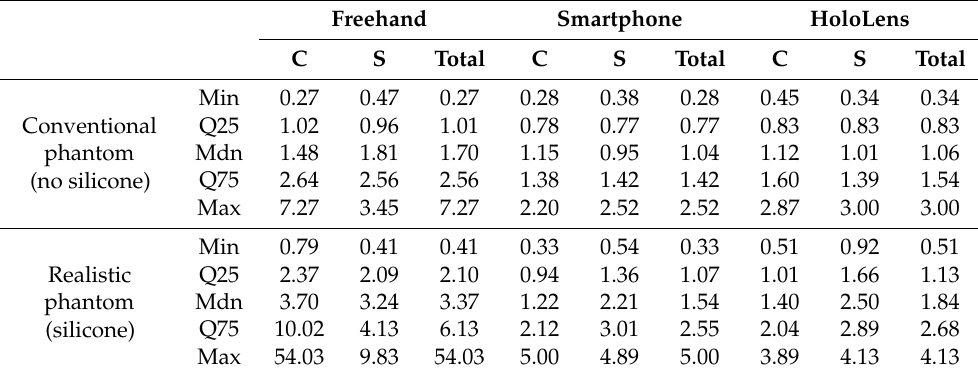
Table 1. Descriptive statistics of maximum osteotomy deviations for each phantom. Q25 and Q75 represent the 25th and 75th percentile. Mdn represents the median. Freehand Smartphone HoloLens C S Total C S Total Conventional